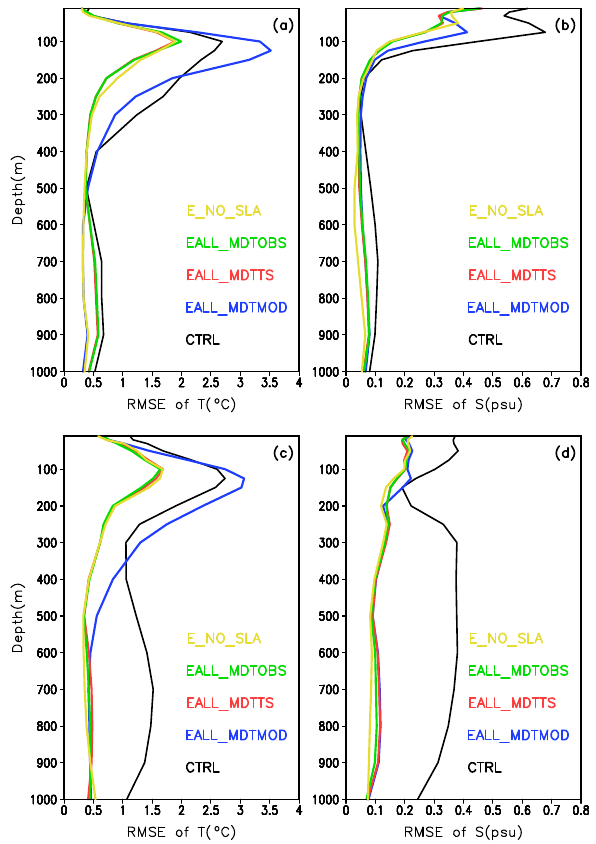
Figure 6. RMSEs of temperature (left; unit: ◦ C) and salinity (right; unit: psu) from different experiments in the northeastern Indian Ocean including the Bay of Bengal (a, b) and the north- western Indian Ocean including the Arabian Sea (c, d) . Black: CTRL; blue: EALL_MDTMOD; red: EALL_MDTTS; green: EALL_MDTOBS; yellow: E_NO_SLA.